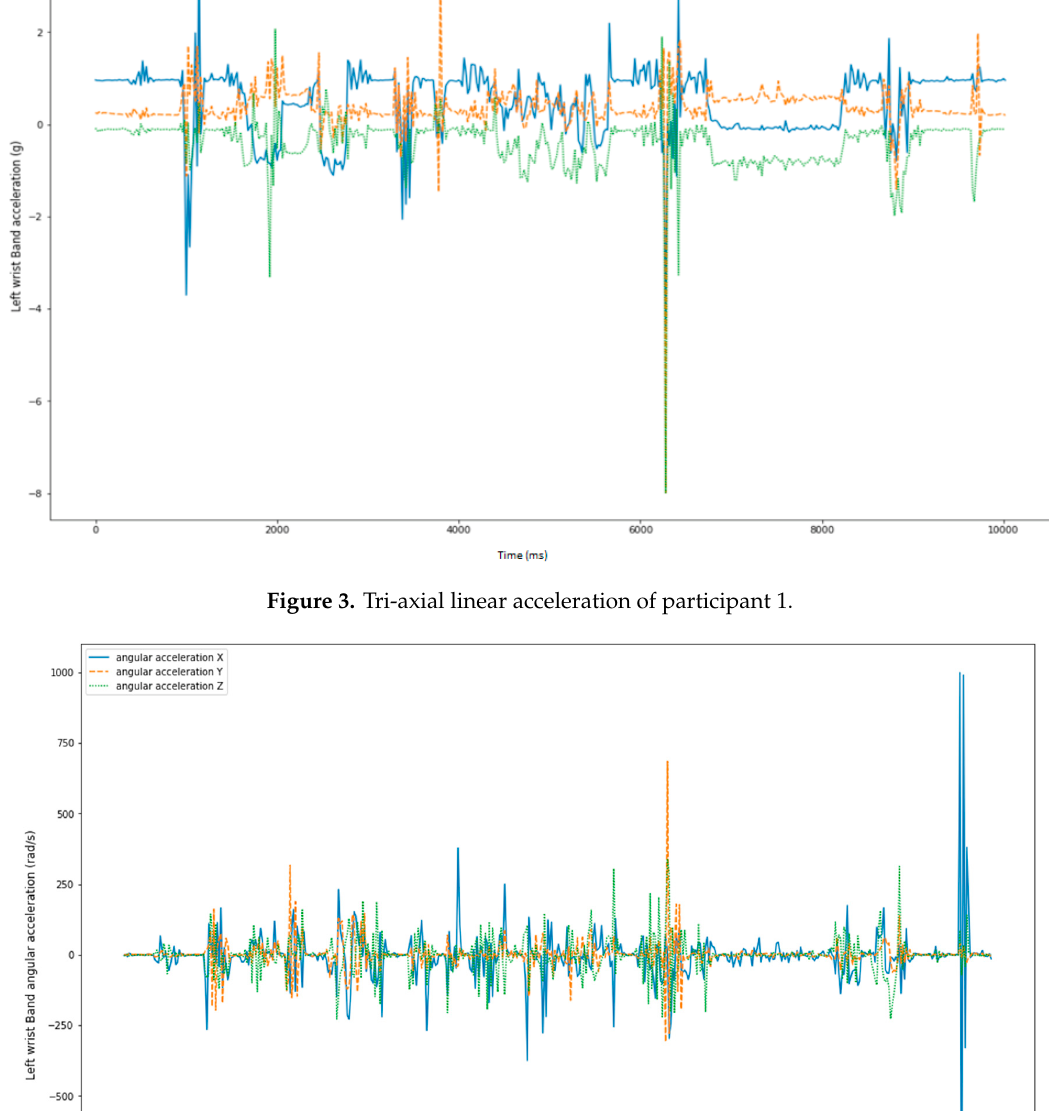
Figure 2. Accelerometer linear acceleration (x-axis).